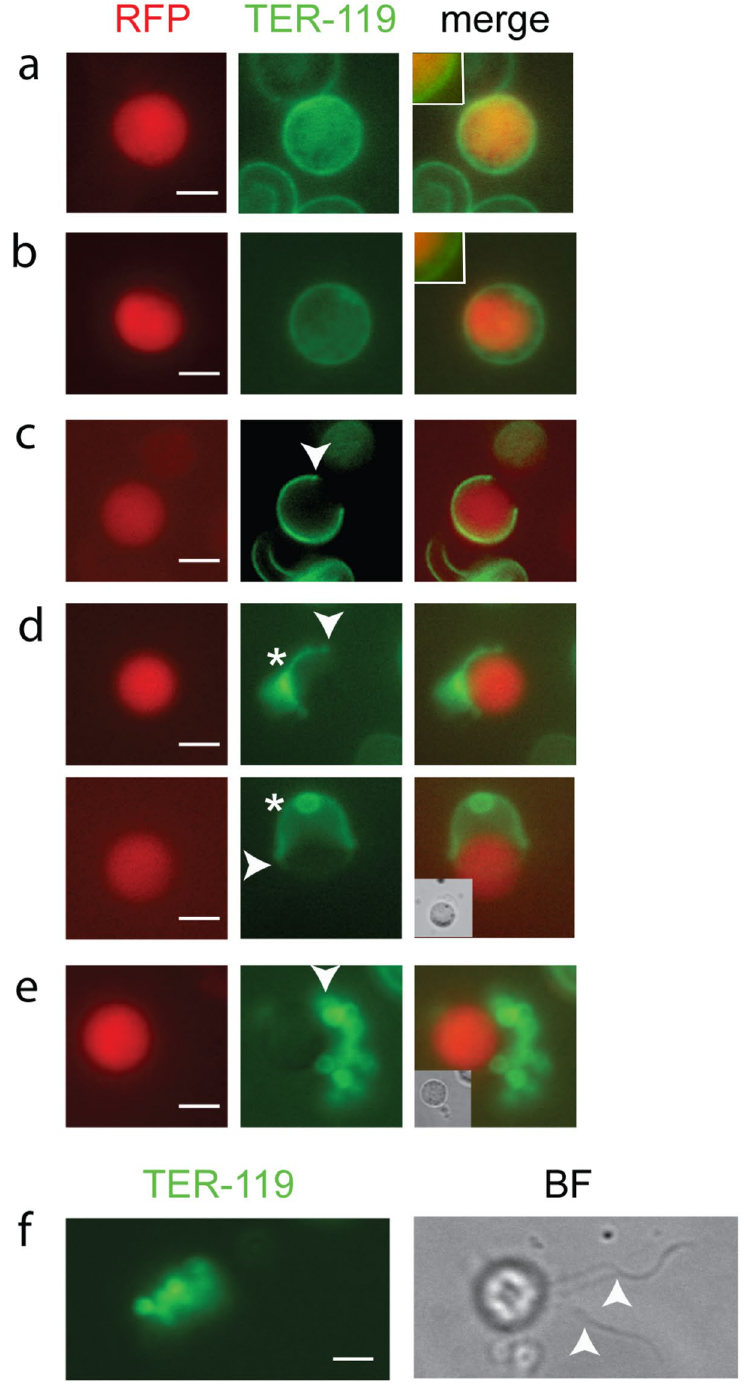
Figure 3. Live imaging reveals RBCM rupture. Samples were imaged without prior fixation. ( a – e ) Female cells expressing RFP (red) and labeled with TER-119 (green). ( a ) A female gametocyte still enclosed in the intact RBCM. The membrane is adjacent to the parasites. ( b ) Swelling of the RBCM membrane is evident. Insets show the adjacent ( a ) and displaced RBCM ( b ) compared to the parasite. ( c ) RBCM opened at a single point. Arrow points to a slight thickening of the membrane at the opening. ( d ) Two cells in the process of egress. The arrows point to a slight thickening of the membrane at the opening. Top panel: The RBCM is opening and simultaneously forming vesicles (asterisks, out of focus), the most common RBCM rupture detected. Lower panel: The RBCM opens as an intact membrane. Compare Fig. 1, female 2 and 3 and Supplementary Information Videos S2, S3. ( e ) Rupture of RBCM completed, and RBCM vesicles remain next to the gamete (white arrow). White arrow heads in ( c – e ) point to opened or vesiculated RBCM. ( f ) Egressed male which is exflagellating. RBCM vesicles remain in proximity to the residual gametocyte and two flagellar gametes are visible (BF image, white arrows). The cells are motile and thus slightly differently located between panels. Scale bar, 5 µ